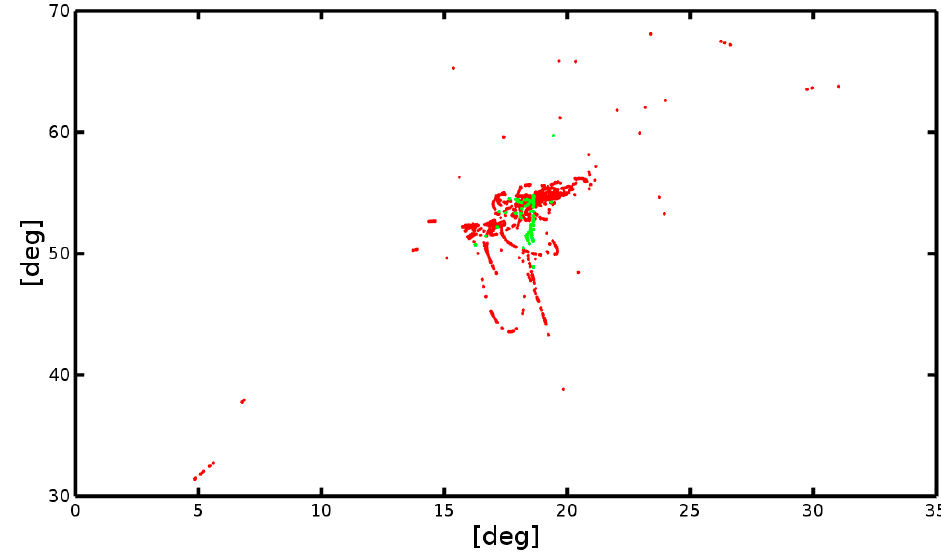
Figure 10. GNSS position accuracy records for the static measurements.